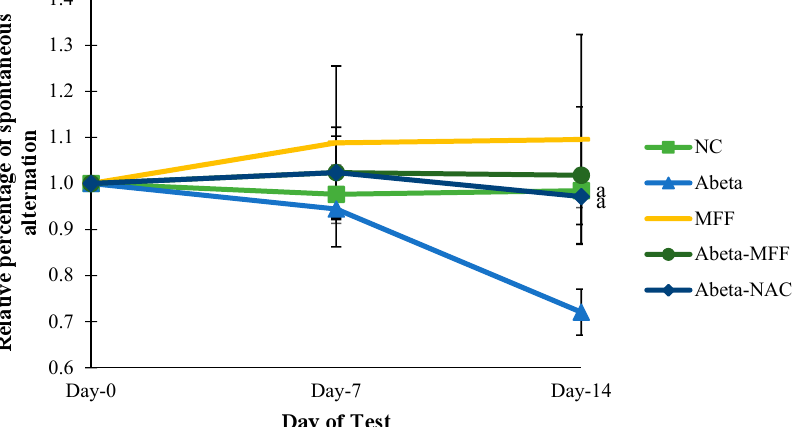
Figure 5. Comparison of the relative percentage of the spontaneous alternation between the groups on day 0, day 7 and day 14. Every bar represents the mean ± SEM ( n = 5). a p < 0.05 compared to Abeta on day 14.